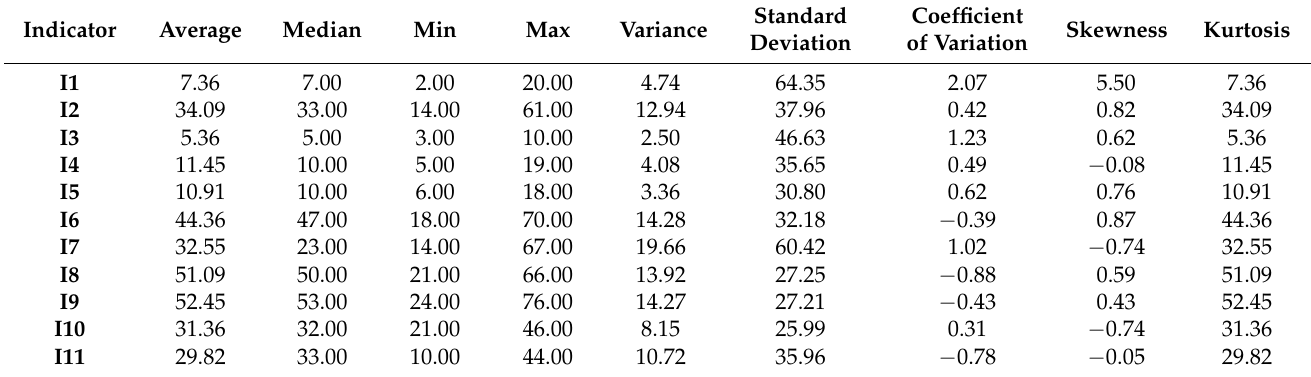
Table 5. Basic descriptive statistics of indicators for medium enterprises in the CEE countries.